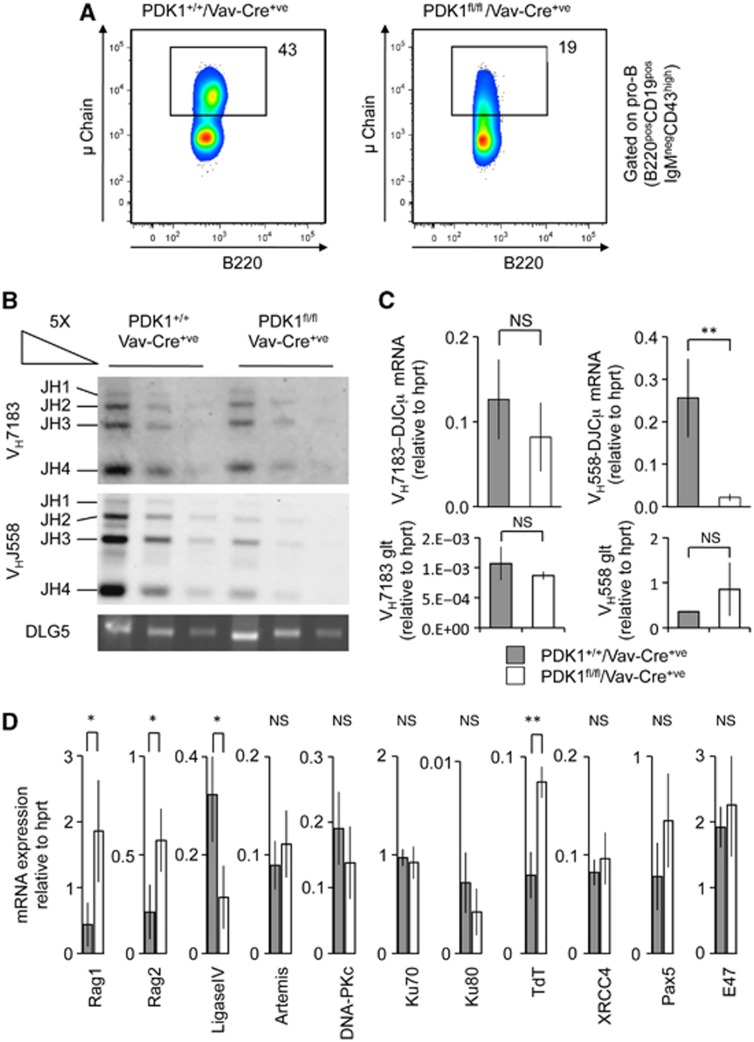
PDK1 deficiency impairs V-DJ recombination. Staining for the presence of intracellular heavy chain in CD19+veIgM−veCD43highB220+ve bone marrow (pro-B) cells demonstrated that while PDK1+/+Vav-Cre+ve cells were able to express the heavy chain, the levels of intracellular heavy chain were reduced in the PDK1fl/fl/Vav-Cre+ve cells. Results are representative of six mice (A). To examine V-DJ recombination, pro-B cells were isolated from PDK1+/+/Vav-Cre+ve and PDK1fl/fl/Vav-Cre+ve mice using FACS sorting. The heavy chain region was amplified by PCR and Southern blotting used to examine recombination for distal (VHJ588) and proximal (VHJ7183) rearrangements (B). V-DJ mRNA expression as well as the expression of the VHJ7183 and VHJ588 germline transcripts was also analysed using qPCR (C) with similar results. Total RNA was isolated from FACS-sorted pro-B cells and the levels of genes involved in V-DJ recombination were determined by qPCR (D). Expression levels were determined relative to HPRT and error bars represent the standard deviation of RNA preparations from FACS-sorted pro-B cells from three independent pools of mice per genotype. Loss of PDK1 resulted in significant increases in the mRNA levels for Rag1, Rag2 and TdT and decreased levels of DNA Ligase IV. In (C, D), a P<0.05 is indicated by * and P<0.01 by ** while NS indicates P>0.05 (Student's t-test).